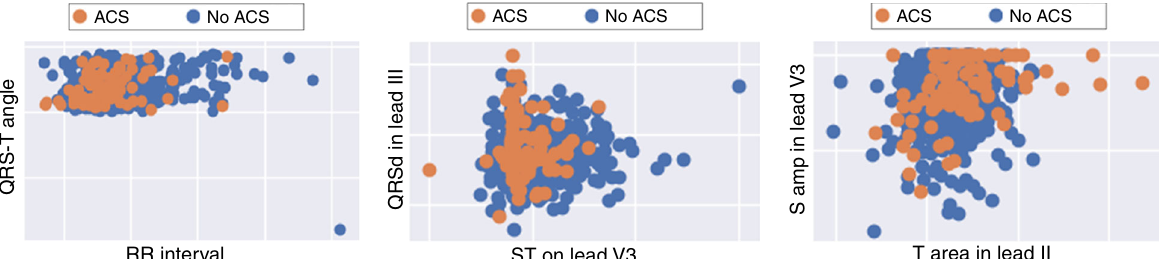
Fig. 4 Scatterplot matrix of some selected features using recursive feature elimination. This fi gure shows selected ECG features with the two- dimensional display scatterplot matrices. These plots show how linear correlations fail to separate patients with or without acute coronary syndrome (ACS), which explains why nonlinear classi fi ers were computationally favored over linear classi fi ers in our